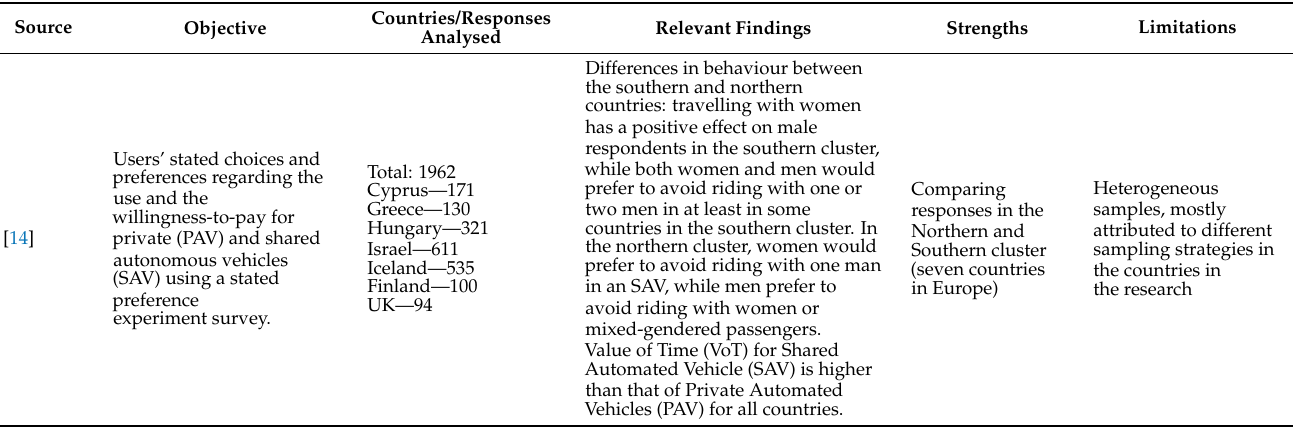
Table 2. Overview of the recent literature discussing SP surveys evaluating AVs acceptance in SEE